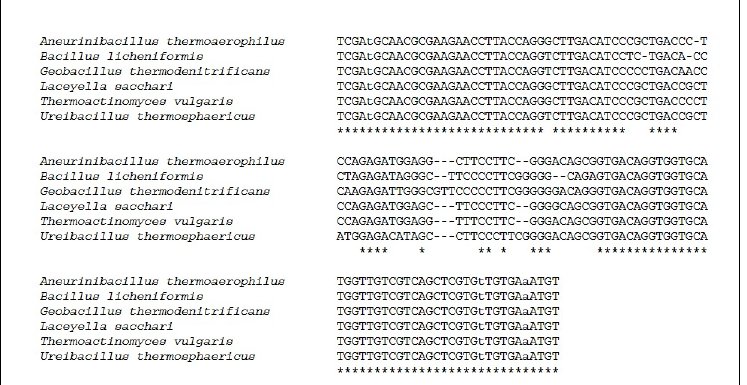
Figure 3. Alignment of the sequences of PCR-no. 2 (Table 2) of the hypervariable region V6. Stars mark matching sequences across all 6 TAS species. Small letters in the primer regions at the beginning and the end of the sequences mark sequence differences due to fixed universal primers (Table 2)